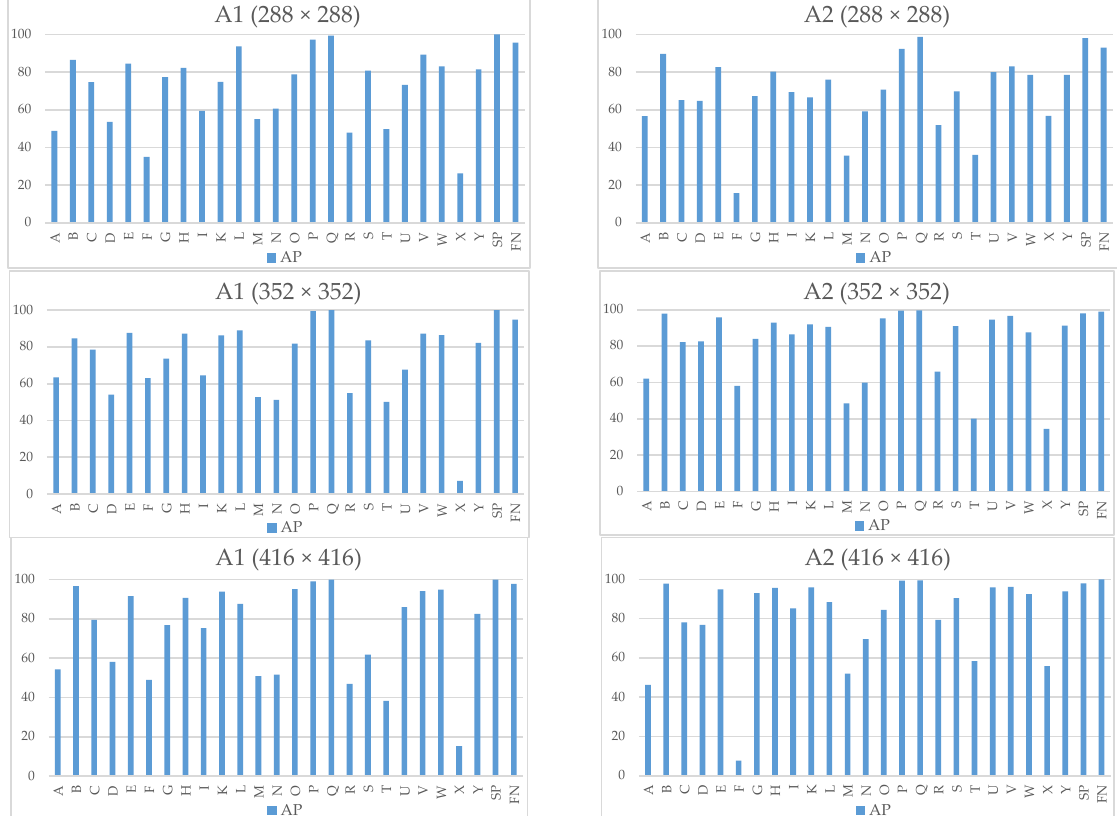
Figure 10. YOLO networks average precision per sign using testset. Since the here presented ASLAT is designed to be used by a single person at a time (in real-time conditions), the SLR subsystem is configured to present the prediction with higher probability. Besides this, the SLR is designed in such a way that a response is issued only if eight (this number is configurable) consecutive images are classified as the same sign. Figure 11 presents the recall of model A2 (352 × 352) for every sign using the 1300 images for testing (testset). This represents how successful the model is to detect presented signs since it depends on the true positives and false negatives. This metric is important to our system since, as previously mentioned, eight consecutive signs must be detected to be issued to the letter sequence to word converter (See Figure 1).